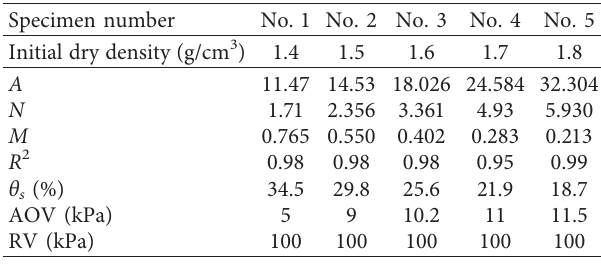
Table 2: Fitting parameters.